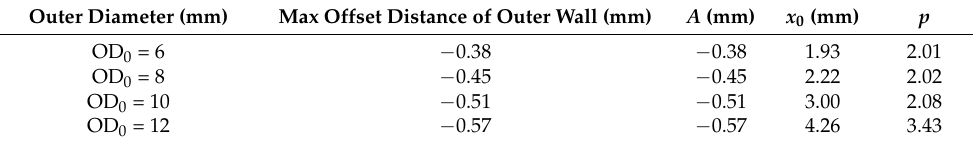
Table 3. Fitted parameters of the Logistic regression model for WT 0 = 1 mm tubes with different OD 0 . Outer Diameter (mm)